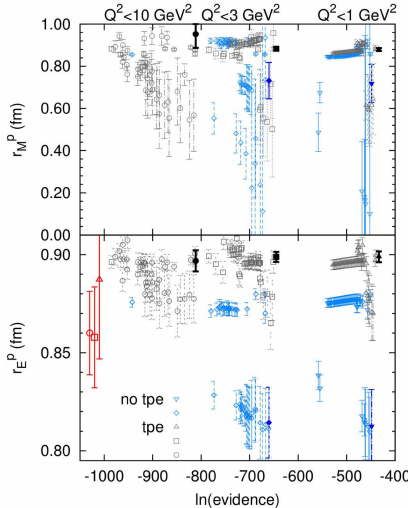
Figure 11. Proton radii from the Bayesian network analysis of [97]. The points in black are corrected for the effects of two-photon